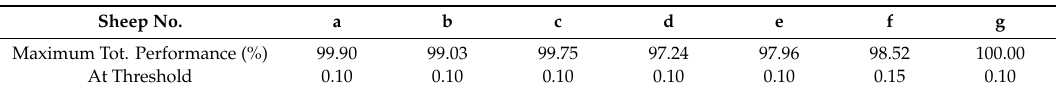
Table 2. Performance of the FFT-type-1-FLC classifier using the band-pass frequency of 80–120 Hz indicated for the best threshold